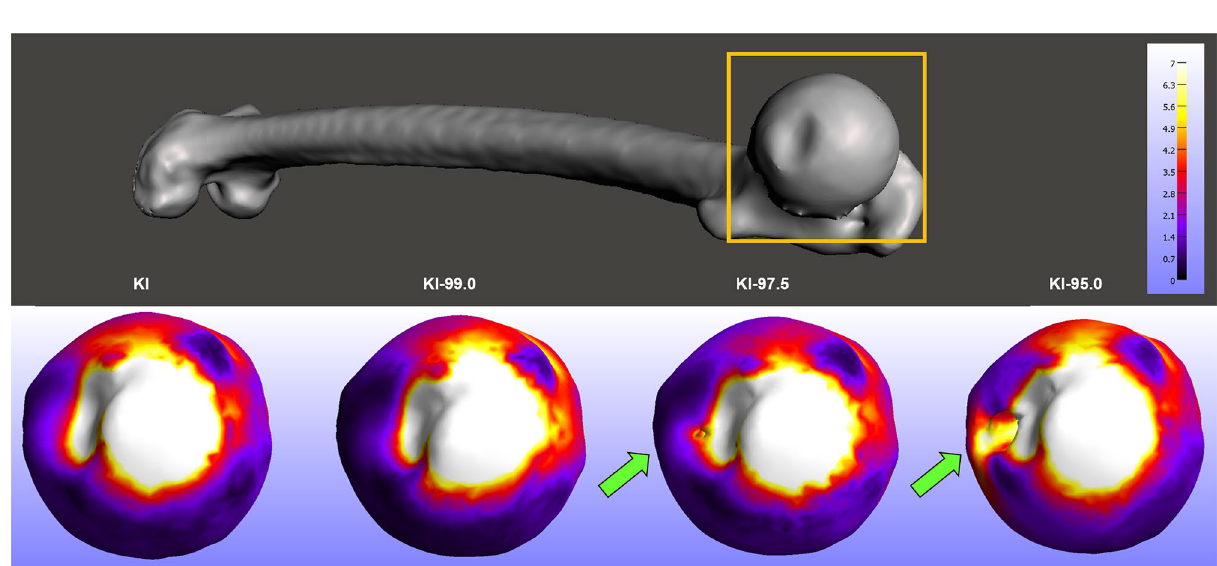
Figure 3. Dissimilarities in regional stress data of finite element models of a right femur specimen generated using 4 different segmentation methods. Arrows indicate a localized development of high stress (MPa) values. 3D mesh visualizations generated with MeshMixer 3.5.474, www. meshm ixer. com; data heatmaps generated with FEBio Studio 1.0.0, https:// febio.